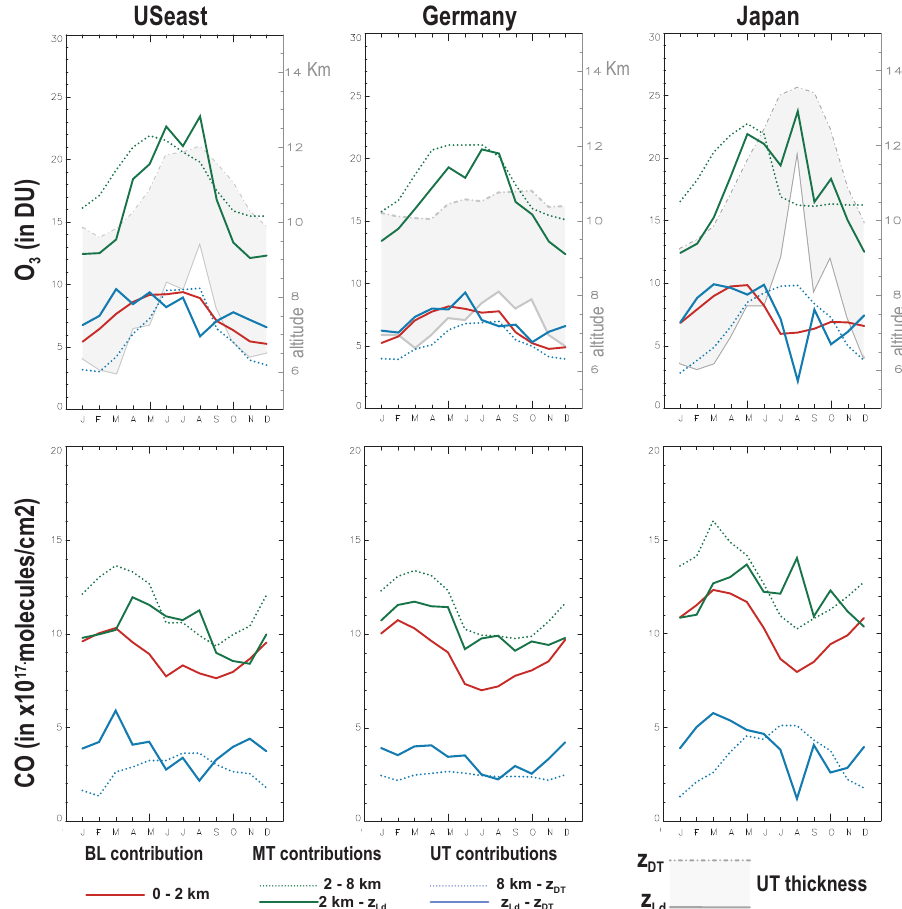
Fig. 12. Tropospheric partial columns: BLC m ( O 3 ) (red), MTC m ( O 3 ) (green) and UTC m ( O 3 ) (blue) for USeast, Germany and Japan (left to right). The previous MTC m [2–8km] and UTC m [8km– z DT ] are the coloured dotted lines and, by using monthly varying limits, the new MTC m [2km– z Ld ], and the UTC m [ z Ld – z DT ] results are the coloured thick lines. O 3 (top row) and CO (bottom row) are expressed in DU and in moleculescm − 2 , respectively. The shaded areas in the O 3 plots highlight the UTC thickness (between z DT and z Ld , the dotted dashed line and the grey line, respectively), referring to the right vertical scale in